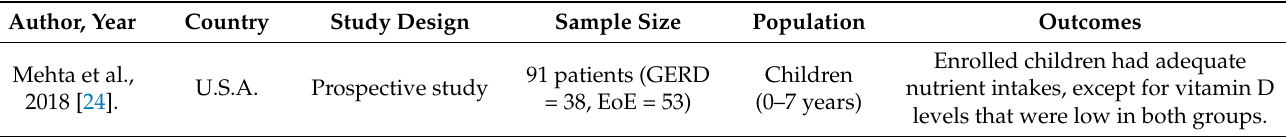
Table 5. Studies reporting levels of vitamin D in children and adult patients with